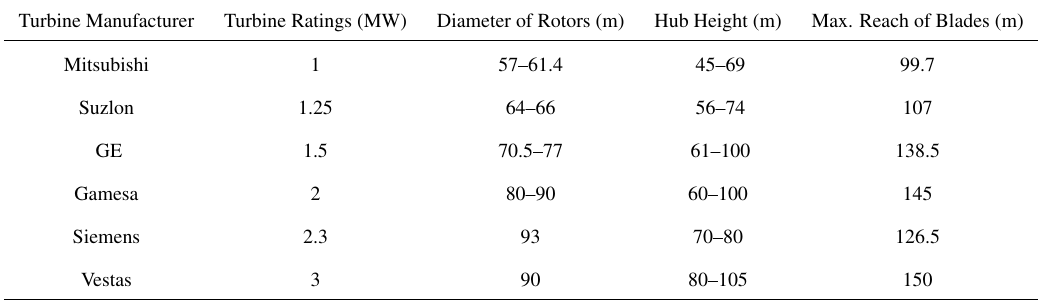
Table 1. Characteristics of selected wind turbines commonly found in the USGP.